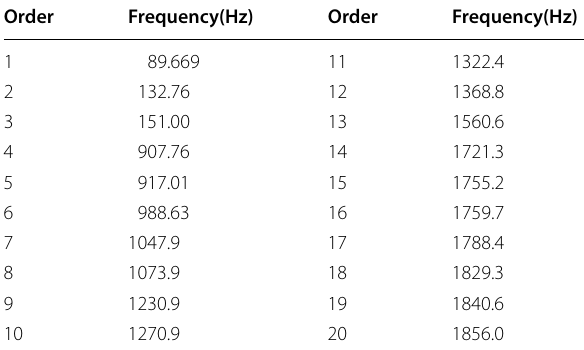
Table 1 The first 20 natural frequencies of